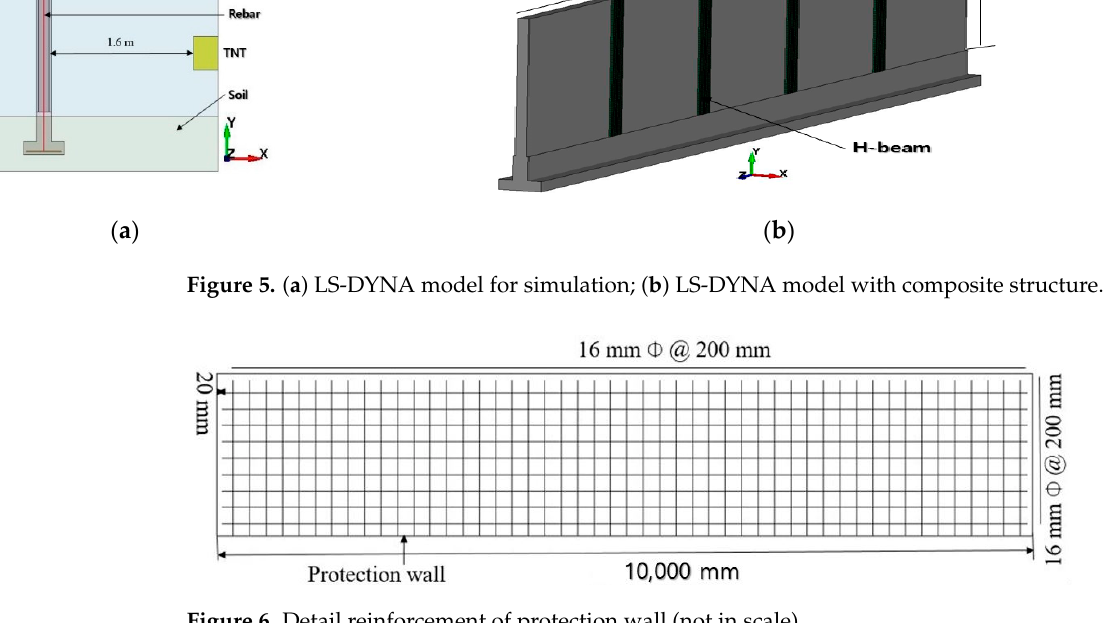
Figure 6. Detail reinforcement of protection wall (not in scale).